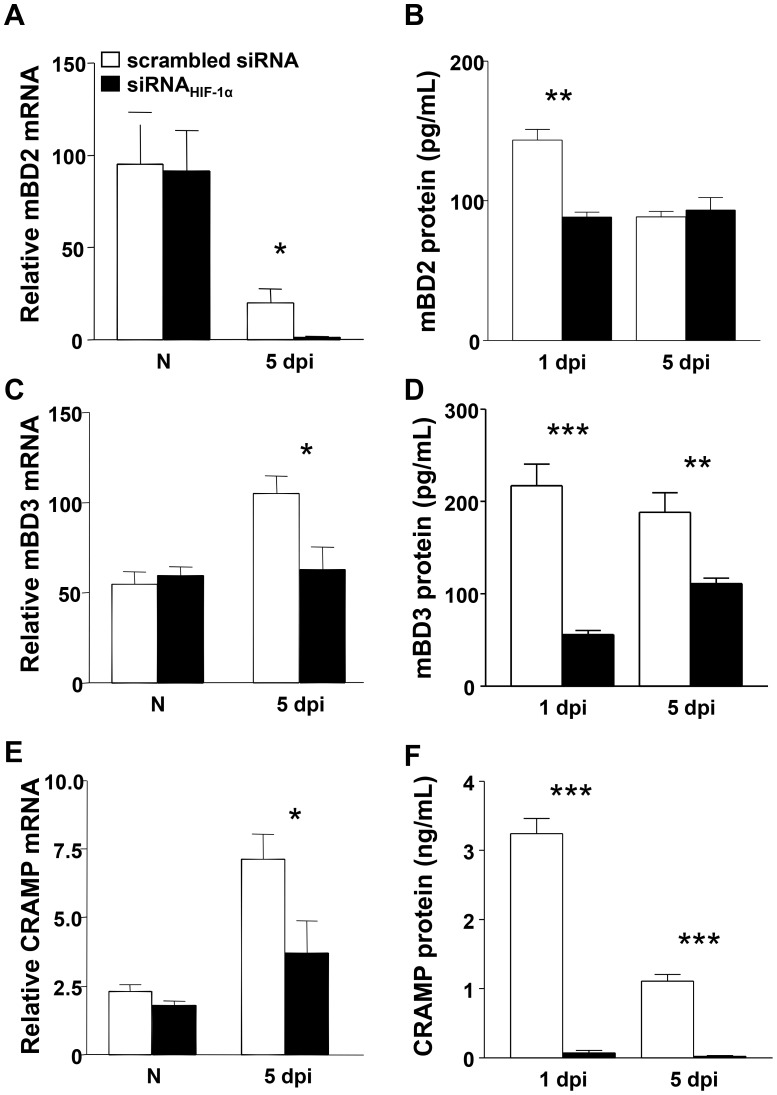
In vivo expression of antimicrobial peptides after HIF-1α silencing.siRNAHIF-1α versus scrambled siRNA mice resulted in significantly decreased mRNA expression for mBD2 (A), mBD3 (C) and CRAMP (E) at 5 days p.i., while there were no differences between the two groups in normal, uninfected corneas. These data were confirmed at the protein level, indicating significant down-regulation of mBD2 (B), mBD3 (D) and CRAMP (F) at both 1 and 5 days p.i. after HIF-1α silencing compared to scrambled controls. Data represent two individual experiments with five mice per group per time point. *P<0.05, ** P<0.01, *** P<0.001.